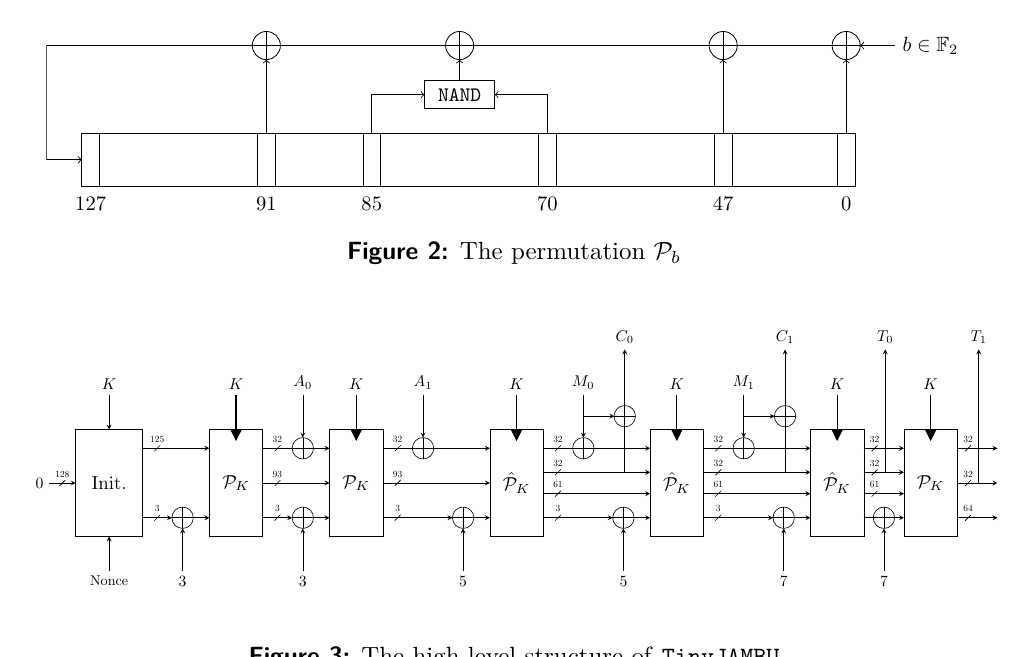
Figure 3: The high-level structure of